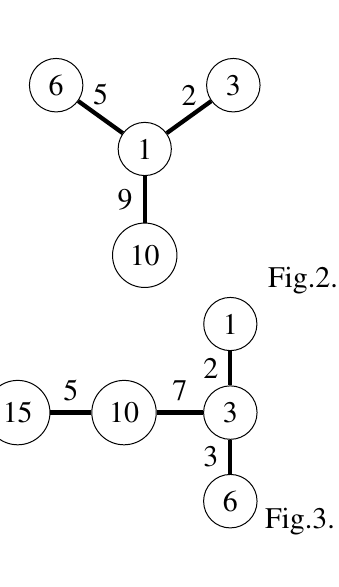
Fig.3. Range Labelling for Spider